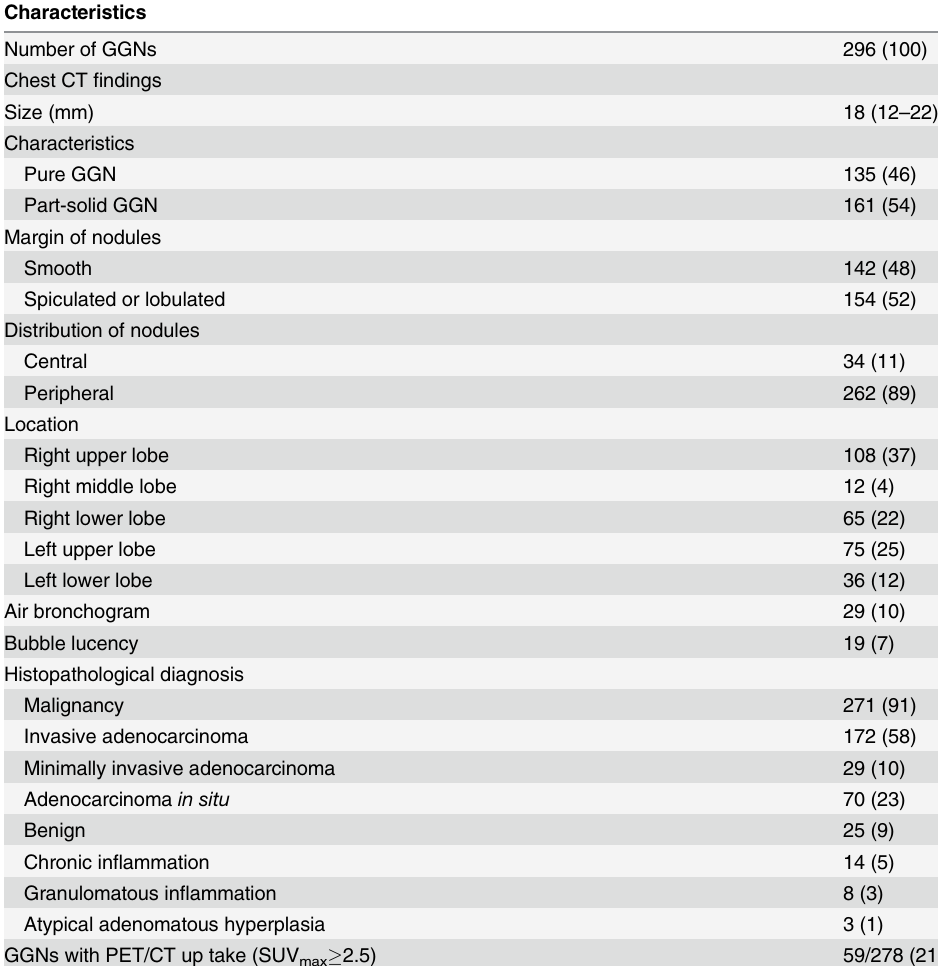
Table 2. Characteristics of GGNs included in the